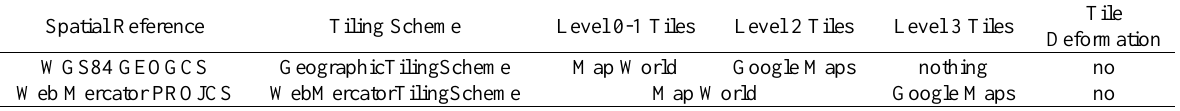
Table 2. Design under the different data sources and same spatial reference